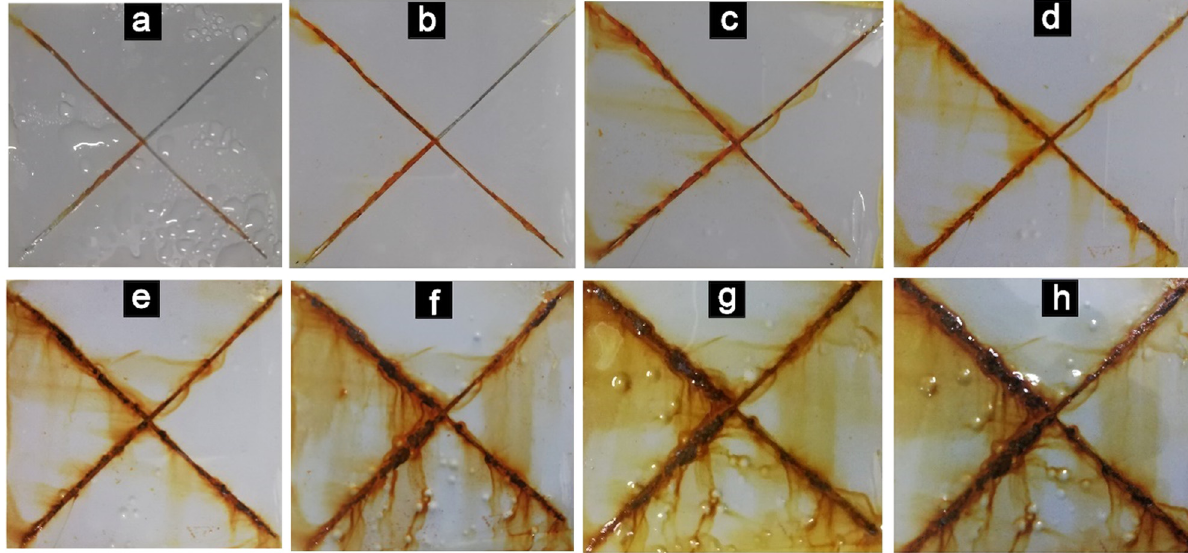
Figure 10: Salt spray test diagram of EL@AR - P 0 fi lm: 48 h ( a ) , 96 h ( b ) , 144 h ( c ) , 192 h ( d ) , 240 h ( e ) , 288 h ( f ) , 336 h ( g ) , 384 h ( h )